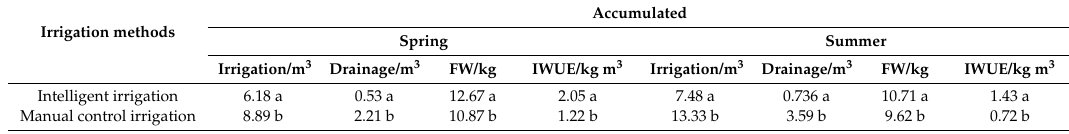
Table 6. Total irrigation, drainage, fresh weight and irrigation water use efficiency for 35 days. Irrigation